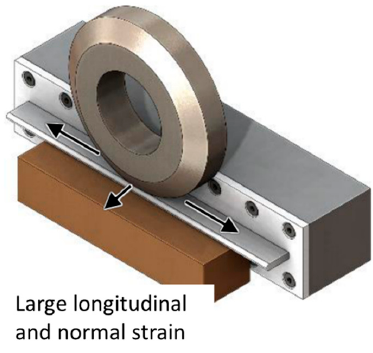
Figure 3. Schematic representation of side rolling of WAAM part to enhance surface finish (adapted from from [19]).